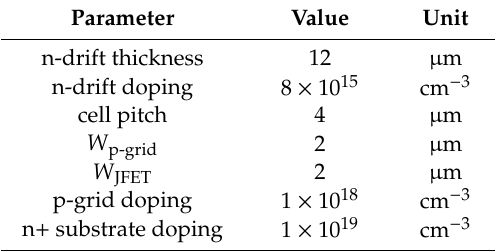
Table 1. Key device parameters in the studied SiC JBS diodes.